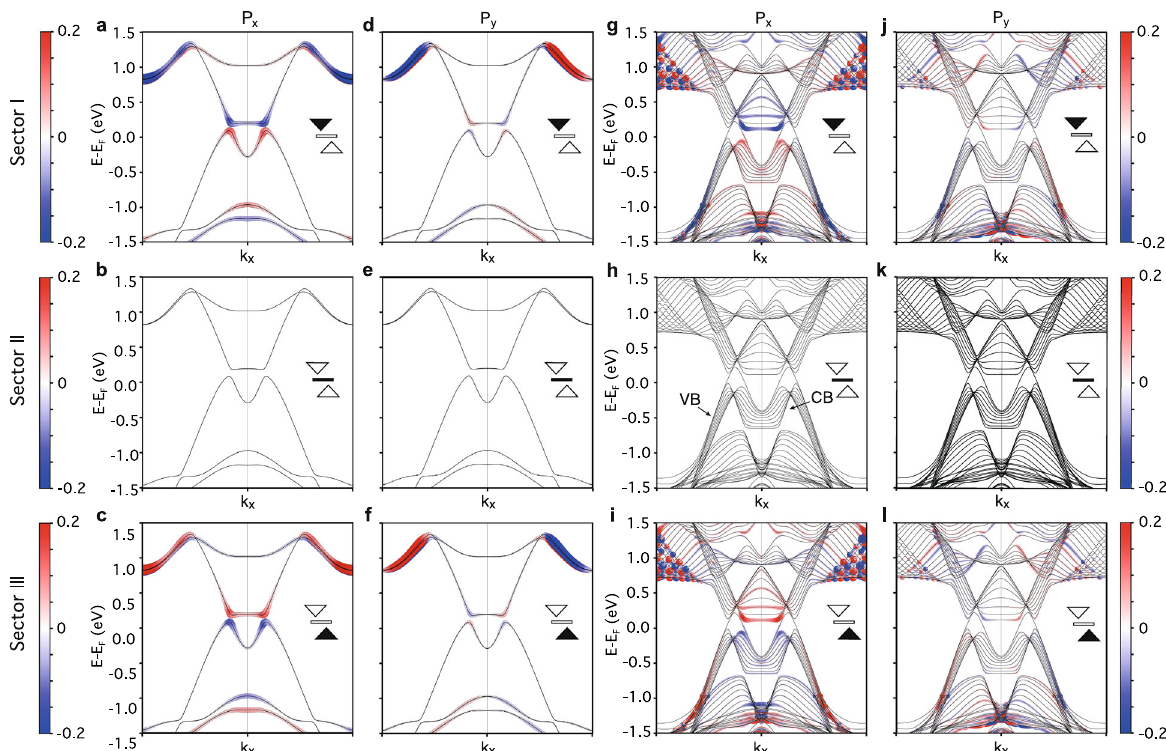
Fig. 4 Calculated bulk spin polarization. Calculated bulk band structure along the dashed line of Fig. 3b. We compare calculations in a – f the bulk and g – l for a slab composed by 9 unit cells. In the former case, the results correspond to the wave vector k z = π / c , while the latter refer to the innermost unit cell of the slab. In both cases, we project the calculations on the different sector, the top and bottom ZrTe sectors are indicated by fi lled wedges, while a fi lled rectangle denotes the intermediated Si plane. The color of the lines encodes in a – c , g – i the P x component and in d – f , j – l the P y component of the local spin polarization. The values of the spin polarization are mapped using a color gradient for both the bulk (on the left) and for the slab (on the right) calculations.